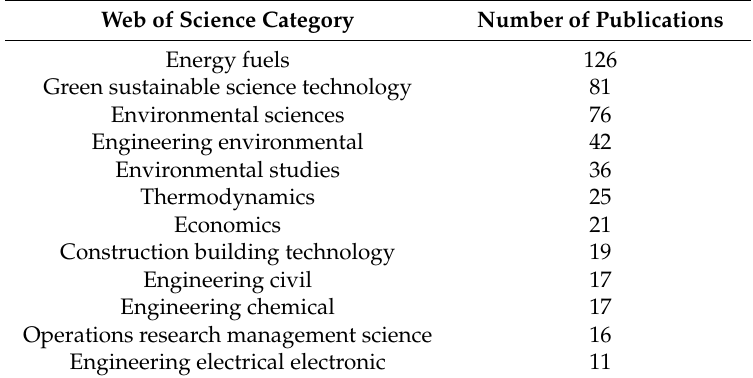
Table 1. The publications by the Web of Science Categories on the topics of “multi-criteria decision making” and “sustainable energy”, 1990–2017.